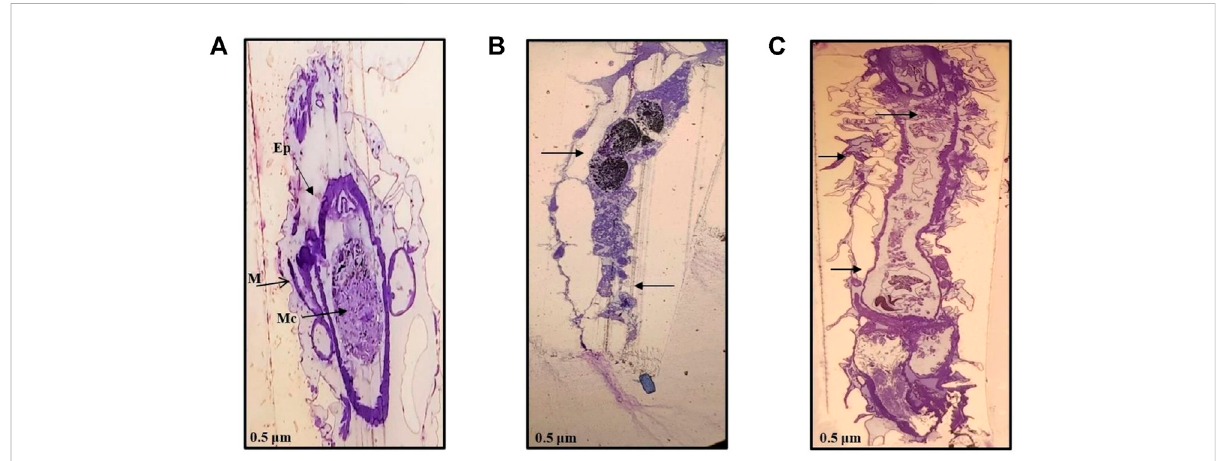
FIGURE 4 Ultra-thin histological sections of early fourth instars of Aedes aegypti: (A) control larva; (B) larva exposed to Achyranthes aspera leaf extract- mediated silver nanocomposites; (C) larva exposed to Achyranthes aspera stem extract-mediated silver nanocomposites. ( → ) indicates damaged